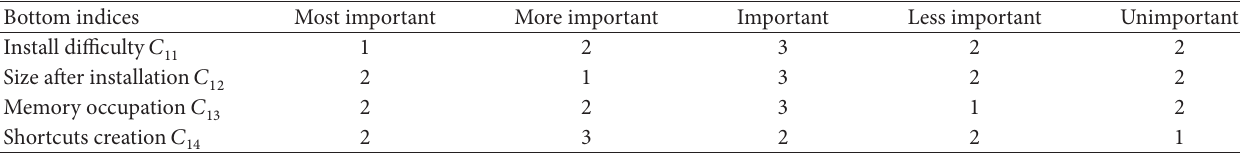
Table 3: Evaluation results given by experts.